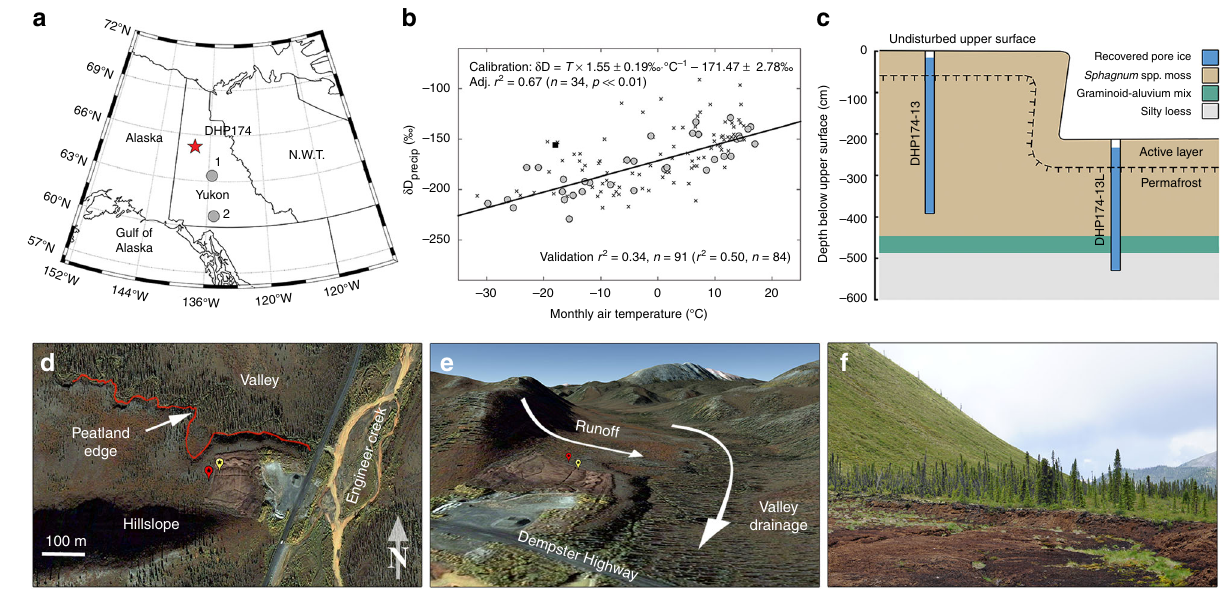
Fig. 1 Study region and DHP174 (Dempster Highway Peatland, near 174 km marker) site. a Regional map showing the DHP174 site (red star) and GNIP (Global Network of Isotopes in Precipitation) sites (1) Mayo and (2) Whitehorse; b the local δ D precip -temperature regression line calibrated with Mayo GNIP data (circles; excluding any leverage points marked with a square, see Methods); the validation r 2 re fl ects the performance of the calibration model in predicting Whitehorse GNIP δ D precip (crosses); the validation r 2 in brackets excludes extreme outlier residuals >2.5× the interquartile range (see Supplementary Fig. 1 for δ 18 O precip -T line); c lithostratigraphy and position of the two core pro fi les (~50m lateral distance); d overhead and e DEM oblique view of the study site — Google Earth and DigitalGlobe satellite images — with points marking the upper (red) and lower (yellow) core site locations; and f ground-level photograph from the peatland edge looking southwest across the disturbed